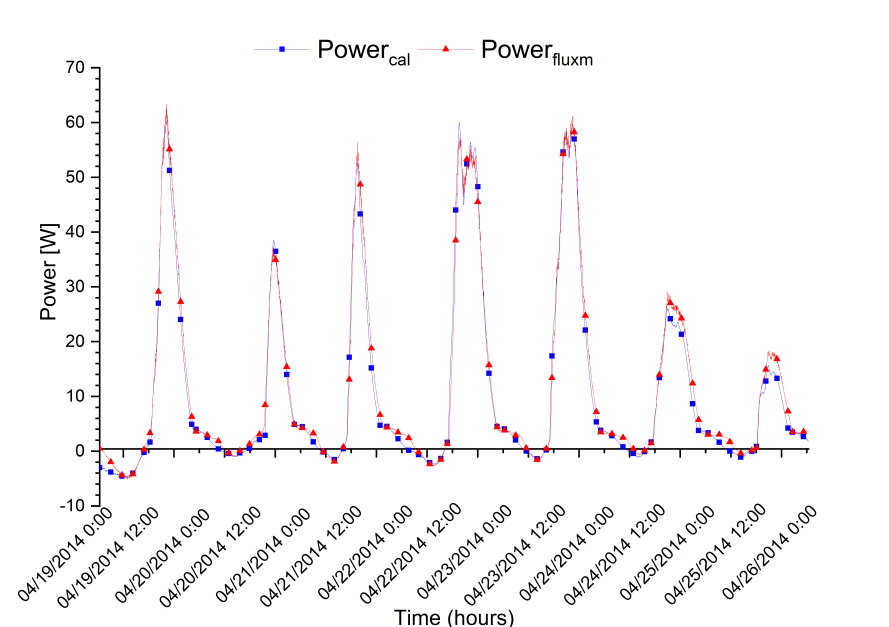
Figure 14. Comparison of the power released by the solar wall. Power cal denotes the power released according to calculation results, while Power fluxm is the power released according to fluxmeter